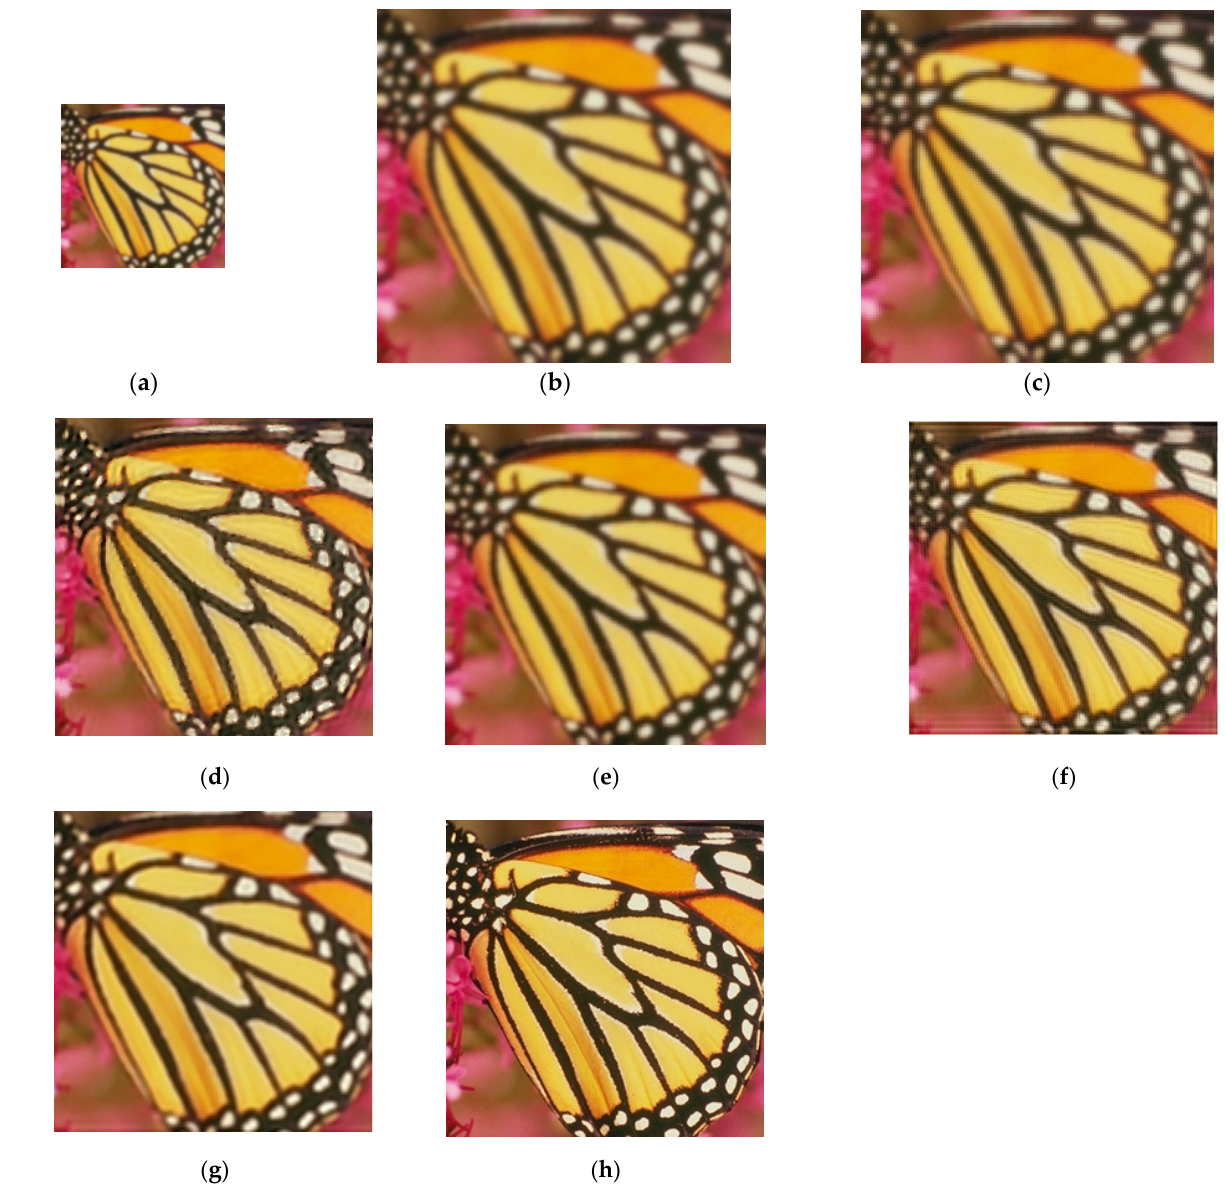
Figure 6. Visual comparison of algorithms for the Butterfly image with 𝜎 (cid:3041)(cid:3042)(cid:3036)(cid:3046)(cid:3032) = 0.005 when the magnification factor is 4. ( a ) The LR image; ( b ) Bicubic interpolation; ( c ) BayesSR; ( d ) SRB; ( e ) DeepSR; ( f ) FBSR; ( g ) Ours; ( h ) ground truth.